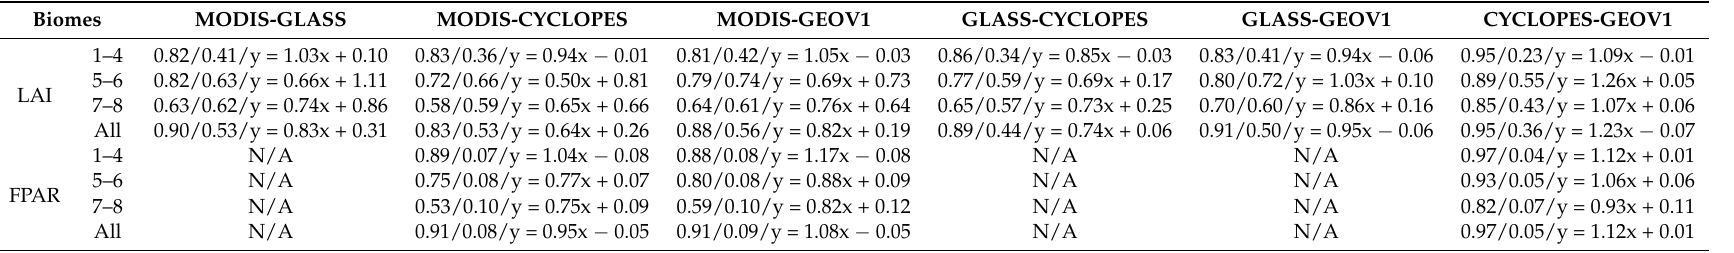
Table 4. Statistics of the intercomparisons among four LAI/FPAR products over BELMANIP sites during 2001–2005. Eight biome types are grouped into three broad categories (1–4: non-forest; 5–6: broadleaf forests; 7–8: needleleaf forests). R 2 , RMSE and regression equations are